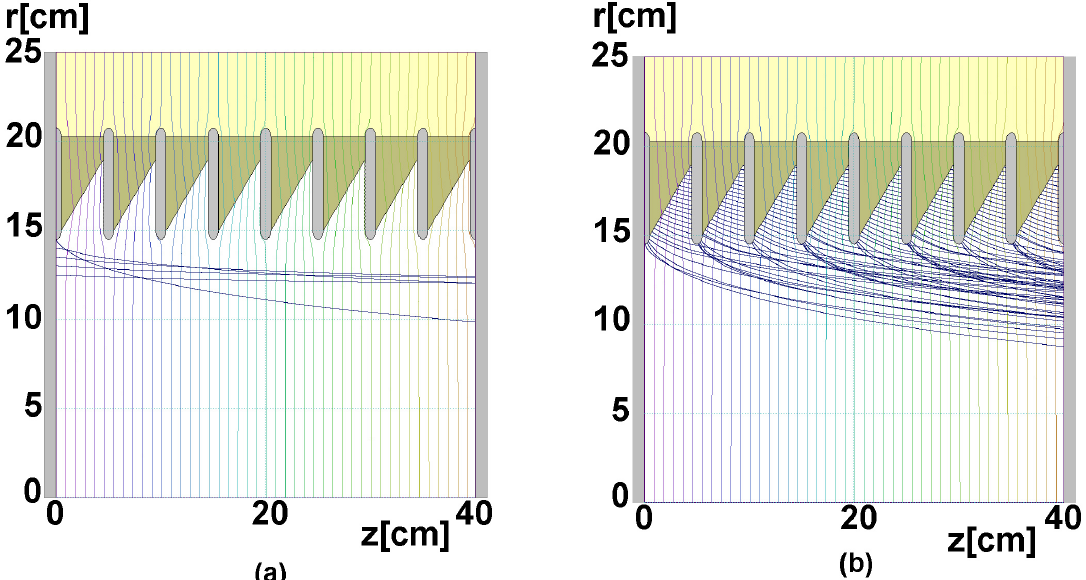
FIG. 3. (Color) Half cross section of an axially symmetric stacked-ring insulator between the parallel cathode (left gray end surface) and anode (right gray end surface). All gray surfaces are conductors, olive colored surfaces are insulators ( " (cid:5) 2 : 7 ). Electrons (blue trajectories) flow from left to right. In (a) electrons are emitted on the cathode is filled with insulating oil ( " r surface. In (b) the trajectories of all possible secondary electrons emitted along the surfaces of the stack are calculated and drawn. The lines almost parallel to the side plates are calculated equipotential curves for 1 MV applied voltage.